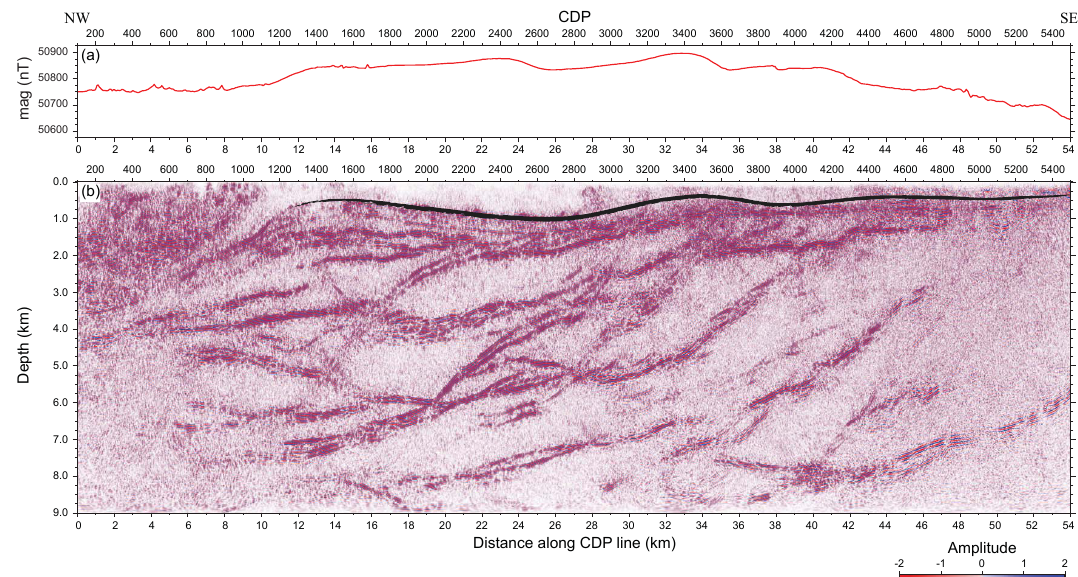
Figure 7. (a) Total magnetic field along the CSP. The anomalies at about CDP 1800, 3100, and 4100 can be interpreted as due to variations in the magnetic basement at depths of 1.3, 1.3, and 1.0km, respectively. (b) Migrated and depth converted stack from Fig. 6 shown at a vertical exaggeration of 2 : 1. The black line marks the depth to the highly conductive layer from MT data as mapped by Yan et al. (2016). An excellent correspondence exists between the base of the uppermost seismically transparent zone and the mapped conductor. Therefore, the onset of reflectivity below the transparent zone is interpreted to represent the top of the uppermost alum shale. Magnetic data are courtesy of the Geological Survey of Sweden